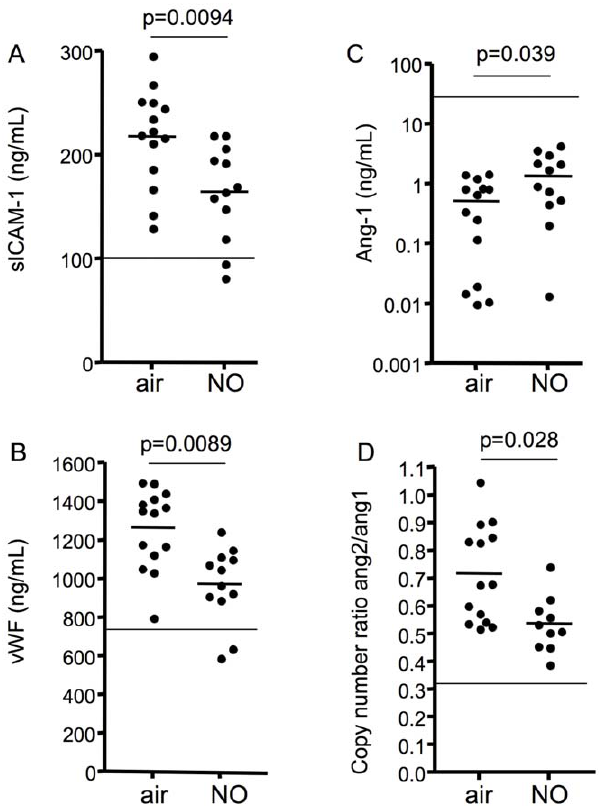
Figure 3. Inhaled NO modulates markers of endothelial activation in mice infected with P. berghei ANKA. (A-C) Heparinized saphenous vein blood was collected on day 5 post- infection from infected mice prophylactically treated with either air or 80ppm NO. Plasma levels of sICAM-1 (A), vWF (B), and Ang-1 (C) were determined by ELISA. The line represents median levels of these factors measured in uninfected mice. (D) Quantitative real time PCR was performed on RNA isolated from brains collected from parasitemia- matched air or 80ppm NO treated mice on day 6 post-infection. The copy number for ang-1 and ang-2 were determined and the ratio between ang-2 and ang-1 is shown. The line represents the copy number ratio in uninfected mice. Statistical differences were assessed using Mann-Whitney. For (A) p=0.0094, for (B) p=0.0089, for (C) p= 0.039, for (D) groups (normalized median (IQR); for ART + air =1.00 (0.76– 1.19) and for ART + iNO = 1.01 (0.95–1.17), p =0.43 by Mann